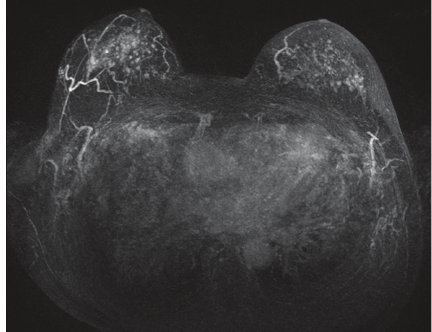
Figure 1: Axial 3D maximal intensity projection of enhanced breast MRI with fat suppression showed numerous foci in bilateral breasts.